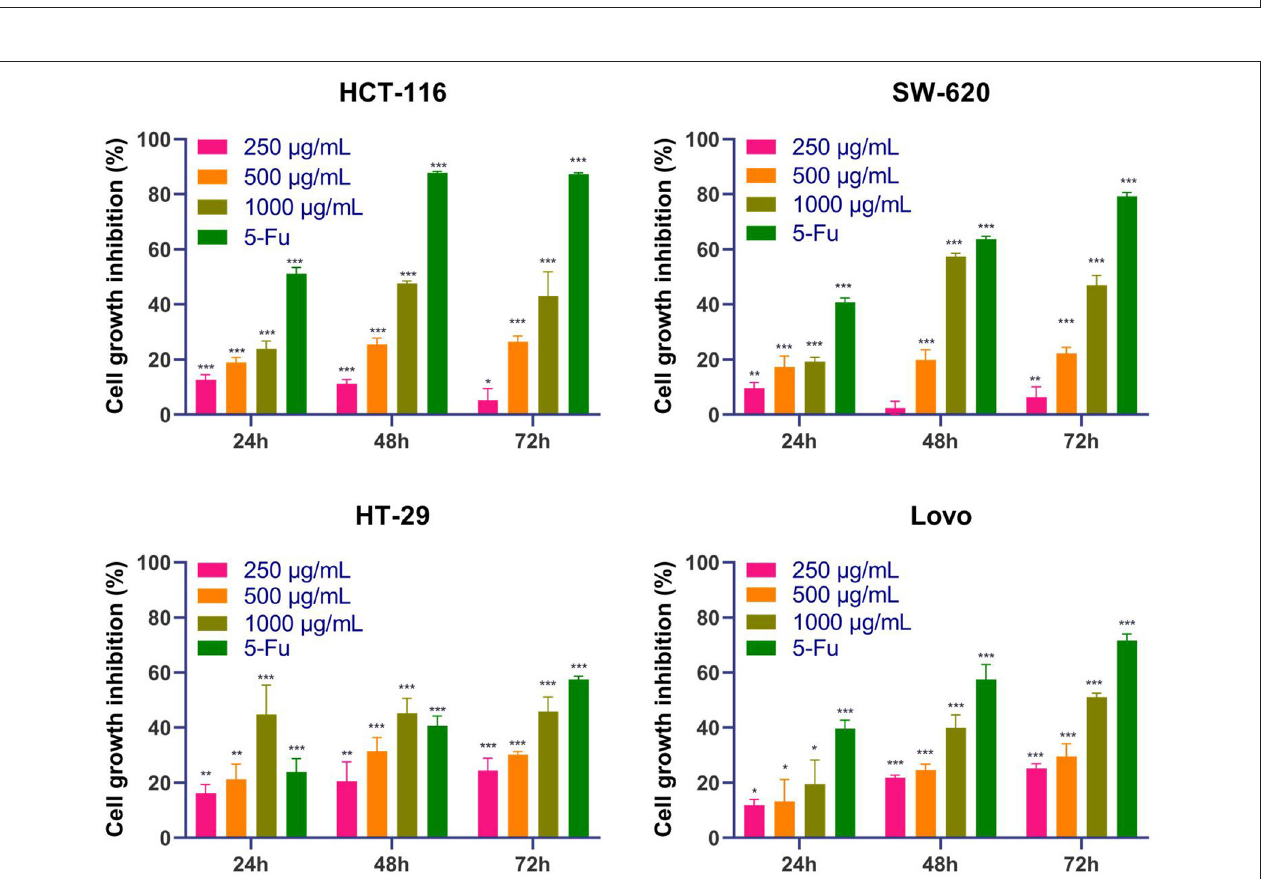
FIGURE 6 | Effects of DOME on the proliferation of CRC cell lines. The cell viability of HT-29, Lovo, SW-620, and HCT-116 cells treated with DOME for 24, 48, and 72h were determined by MTT assay. The error bars represent SEM (* P < 0.05, ** P < 0.01, *** P < 0.001, when compared with blank group).